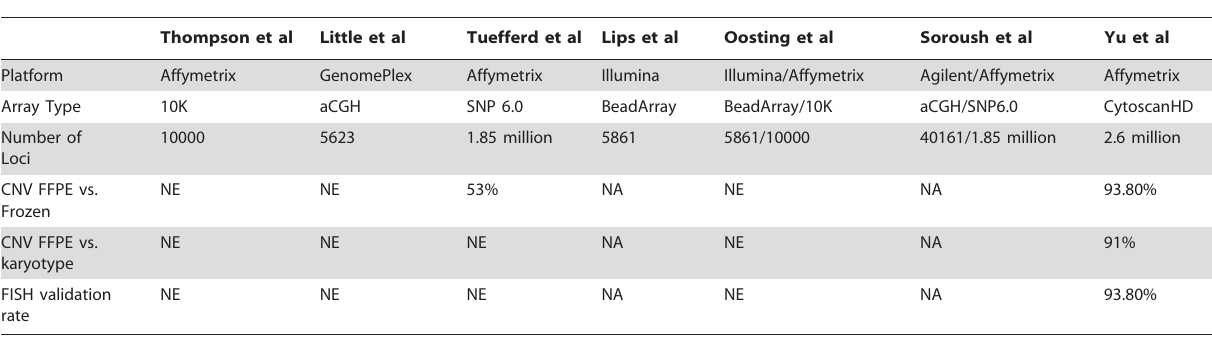
Table 5. Comparison of methods analyzing CNV using FFPE